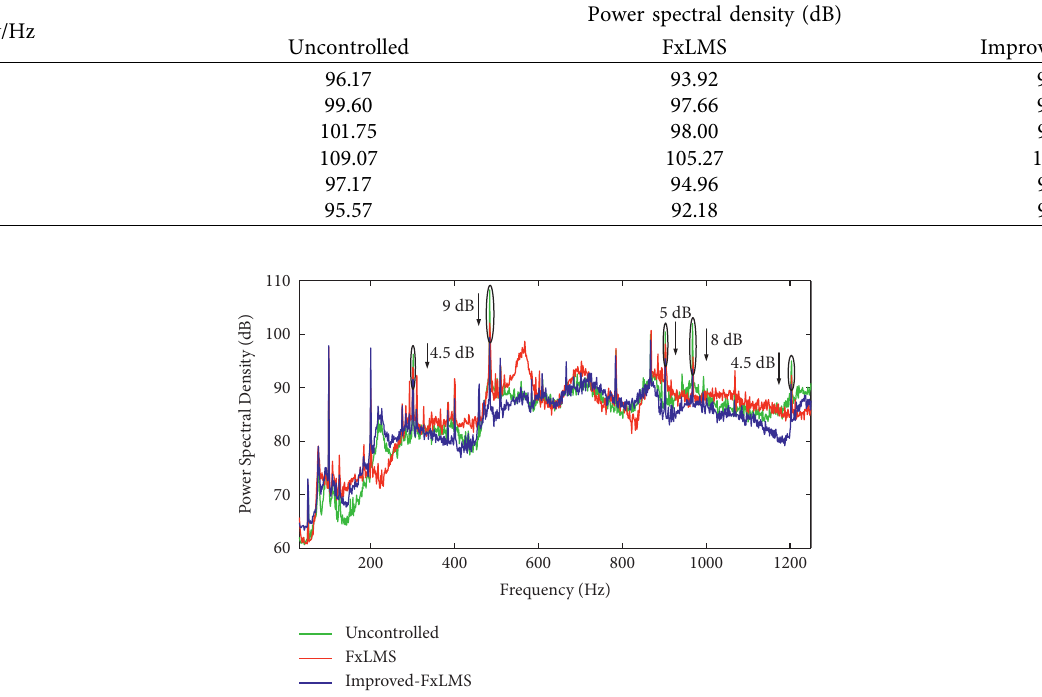
Figure 16: Vibration frequency domain control diagram at